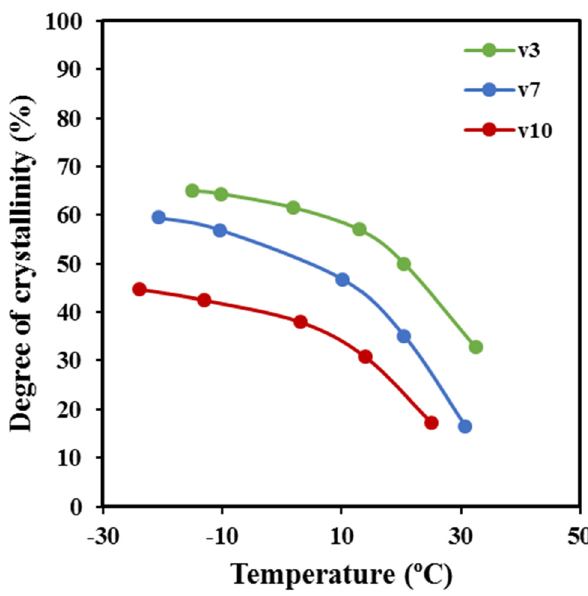
Figure 14. Evolution of the absolute degree of crystallinity determined from WAXD profiles with temperature for the indicated cooling rates.